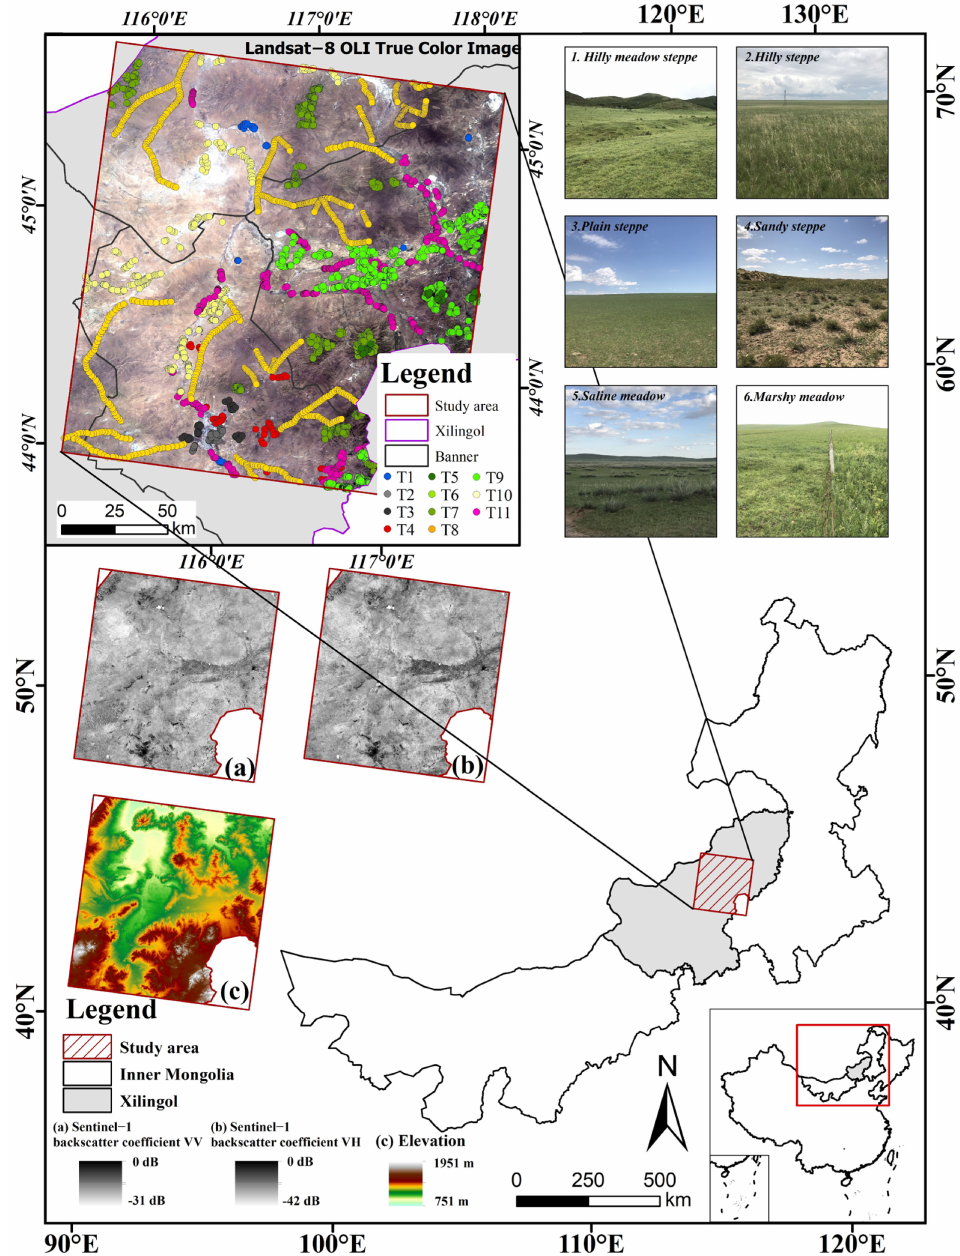
Figure 1. Location of the study area and distribution of the sample points. A total of 3620 samples across the above-mentioned land covers were collected through field observation (taking photos and GPS positioning) combined with high-resolution imagery, Gaofen (2.5 m × 2.5 m), from July to August 2017 (Figure 1). After that, these samples were randomly divided into training and testing datasets in a ratio of 7:3. The distribution of samples for each land cover is shown in Table